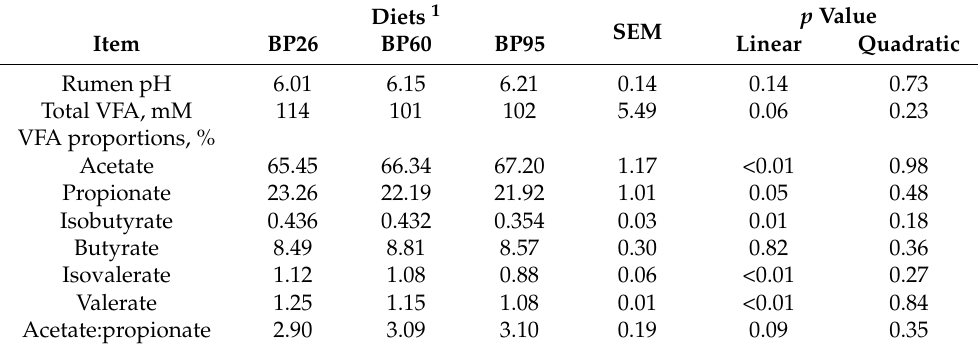
Table 5. Effect of replacing human-edible feed ingredients with byproducts on rumen pH and